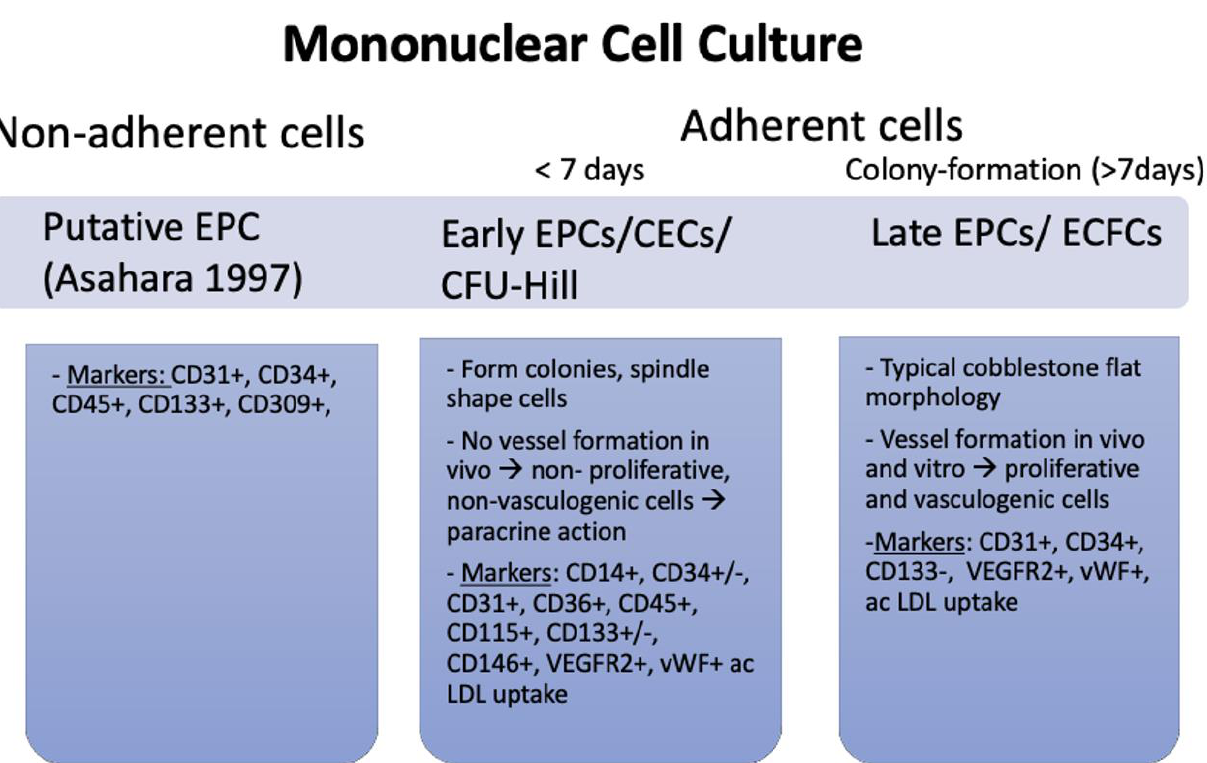
Figure 1. Three different types of EPCs, their function and associated markers. In Asahara et al.’s method, non-adherent cells were cultivated, whereas in the protocols by CFU-Hill and Ingram, only adherent cells were used. The three cell cultures each have a distinct morphology, specific functions in vivo and display discriminating markers [8].